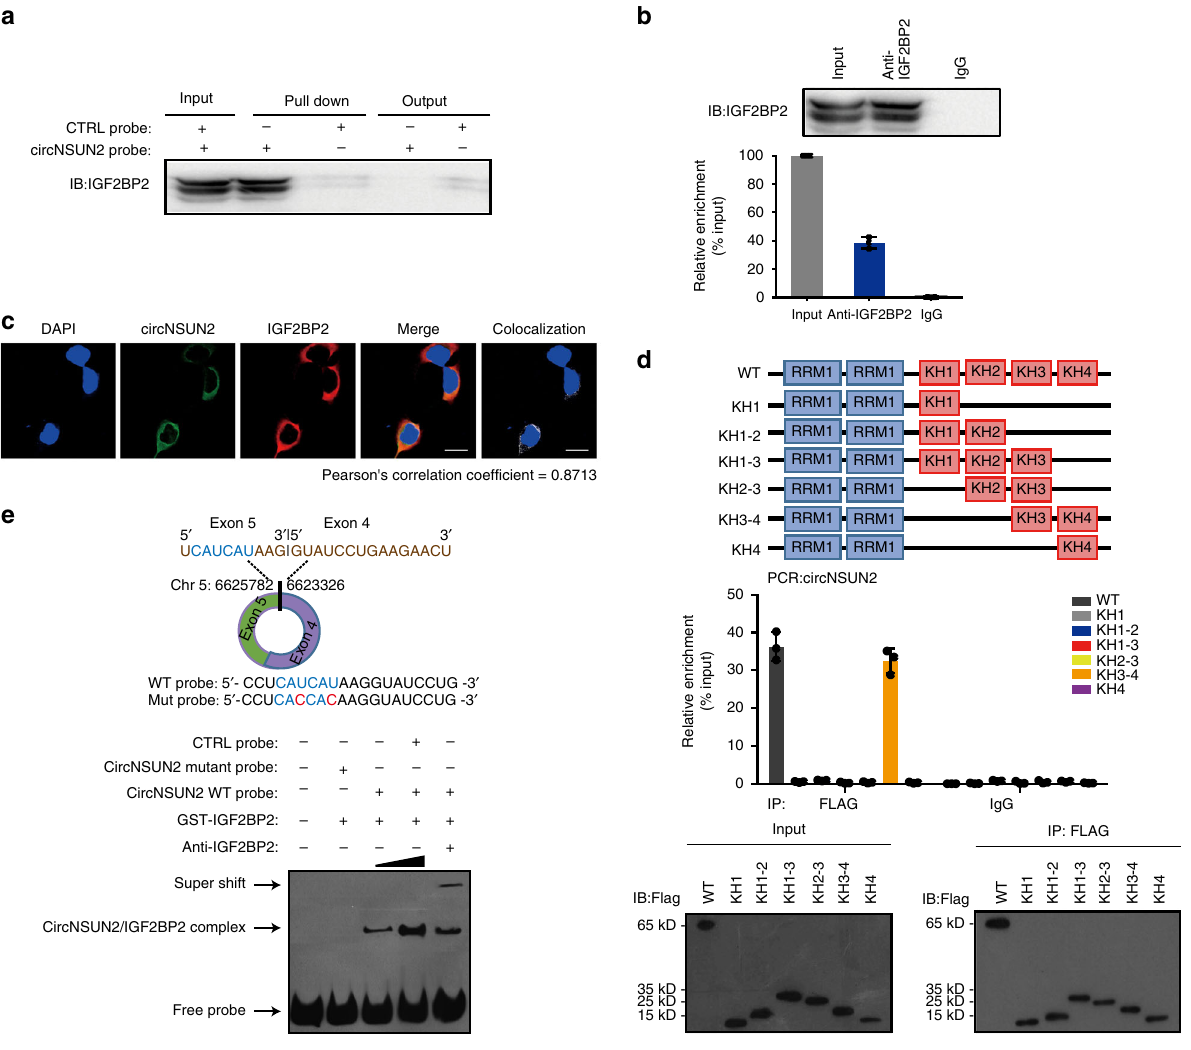
Fig. 5 CircNSUN2 interacts with IGF2BP2 through CAUCAU motif. a Immunoblot analysis of IGF2BP2 after RNA-pulldown assay showing its speci fi c association with circNSUN2. b RIP assays showing the association of IGF2BP2 with circNSUN2. Relative enrichment representing RNA levels associated with IGF2BP2 compared to an input control. IgG antibody served as a control. Data represent mean ± S.D. from three independent experiments; dot plot re fl ects data points from independent experiment. c IF-FISH assay showing that circNSUN2 is colocalized with IGF2BP2 protein in the cytoplasm. Scale bar, 10 µ m. d Top, schematic structures showing RNA-binding domains within IGF2BP2 protein and a summary of IGF2BP2 truncations. Middle, relative enrichment representing circNSUN2 levels associated with truncated IGF2BP2 relative to an input control. Bottom, immunoblot analysis with anti-FLAG of HCT116 cells transfected with plasmids encoding FLAG-tagged WT or truncated IGF2BP2s. Data represent mean ± S.D. from three independent experiments; dot plot re fl ects data points from independent experiment. e Top, schematic illustration showing the CAUCAU motif located at exon 5 − exon 4 junction site of circNSUN2 and the RNA probe for RNA-EMSA assay. Bottom, RNA-EMSA assay showing the binding ability of puri fi ed IGF2BP2 with biotin-labeled oligonucleotides containing CAUCAU motif from circNSUN2. Source data are provided as a Source Data fi le. Unprocessed original scans of blots are shown in Supplementary Fig.